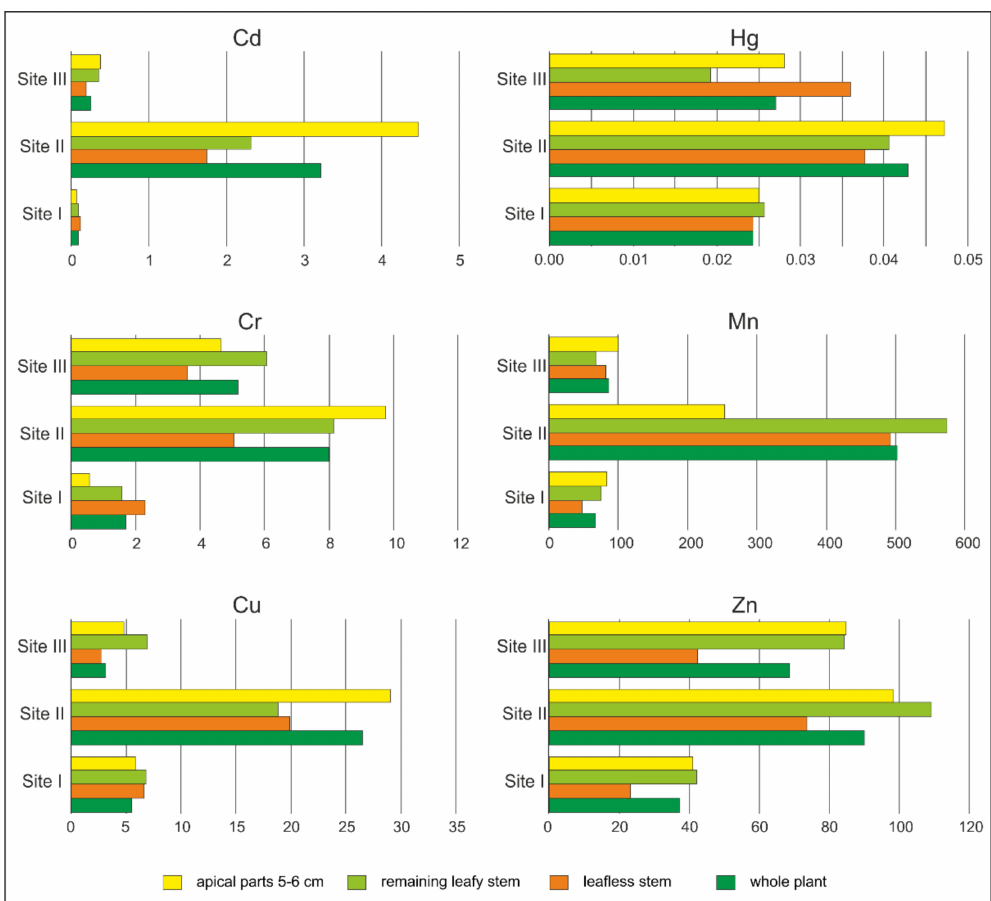
Figure 2. Accumulation of the studied elements (mg · kg − 1 d.m.) in the separated parts of G. densa .